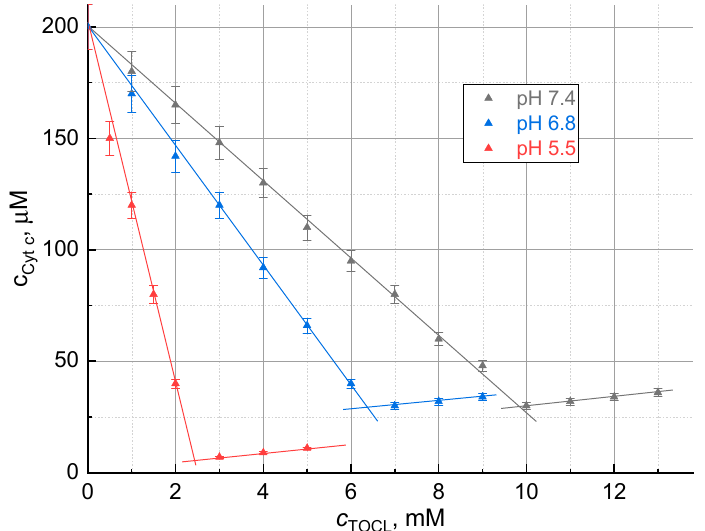
Figure 1. Dependence of the concentration of ferricytochrome c in the supernatant on the concentration of added cardiolipin at di ff erent pHs, 409 nm. Titration curves for pH 4.1 and 3.7 are not shown, they coincide with the curve at pH 5.5. At the in fl ection points, the complex in dissolved form is in equilibrium with the precipitate. After the in fl ection points, absorbance increases due to light sca tt ering of excess cardiolipin appearing in solution.